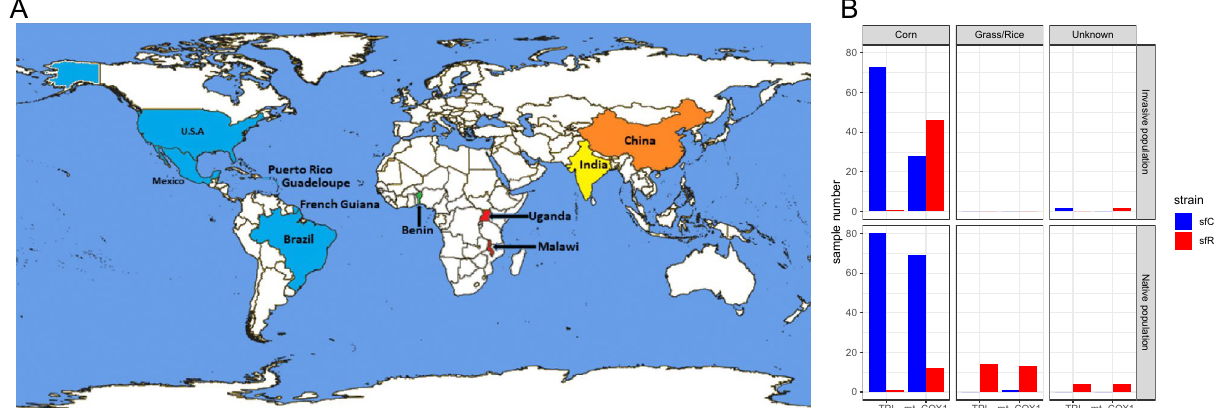
Figure 1. Samples used in this study ( A ) Map indicating the countries from which samples of Spodoptera frugiperda were sequenced. The blue color indicates the native countries of S. frugiperda . The green, red, yellow, and orange colors indicate that the invasion was reported in 2016, 2017, 2018, and 2019 respectively. The map was generated using MapChart 42 . ( B ) The numbers of sfC and sfR samples according to the host plants using different diagnostic markers (TPI or mitochondrial COX1).